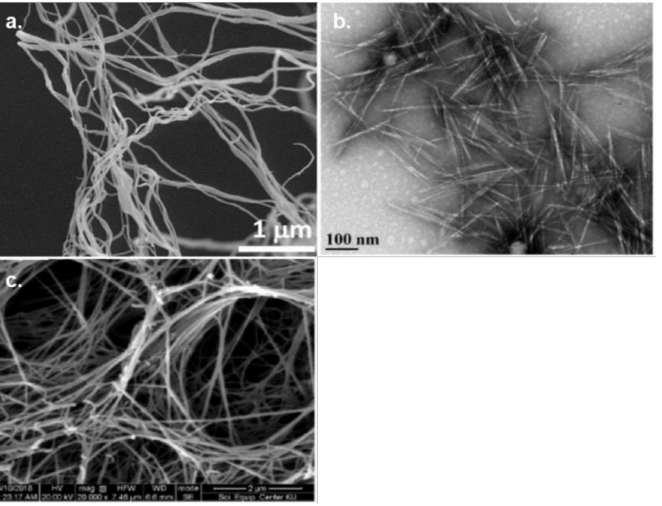
Figure 8. Different types of nanomaterials: ( a ) cellulose nanofibrils (CNFs) obtained from mechanical disintegration of pinewood cellulose, ( b ) cellulose nanocrystals (CNCs) obtained from sulfuric acid hydrolysis of filter paper, and ( c ) bacterial cellulose obtained from culture of Komagataeibacter xylinus . Reprinted, ( a ) from ref. [182] © 2021 with permission from Elsevier, ( b ) from ref. [181] as distributed by Creative Common CC BY license, ( c ) from ref. [183] © 2021 with permission from